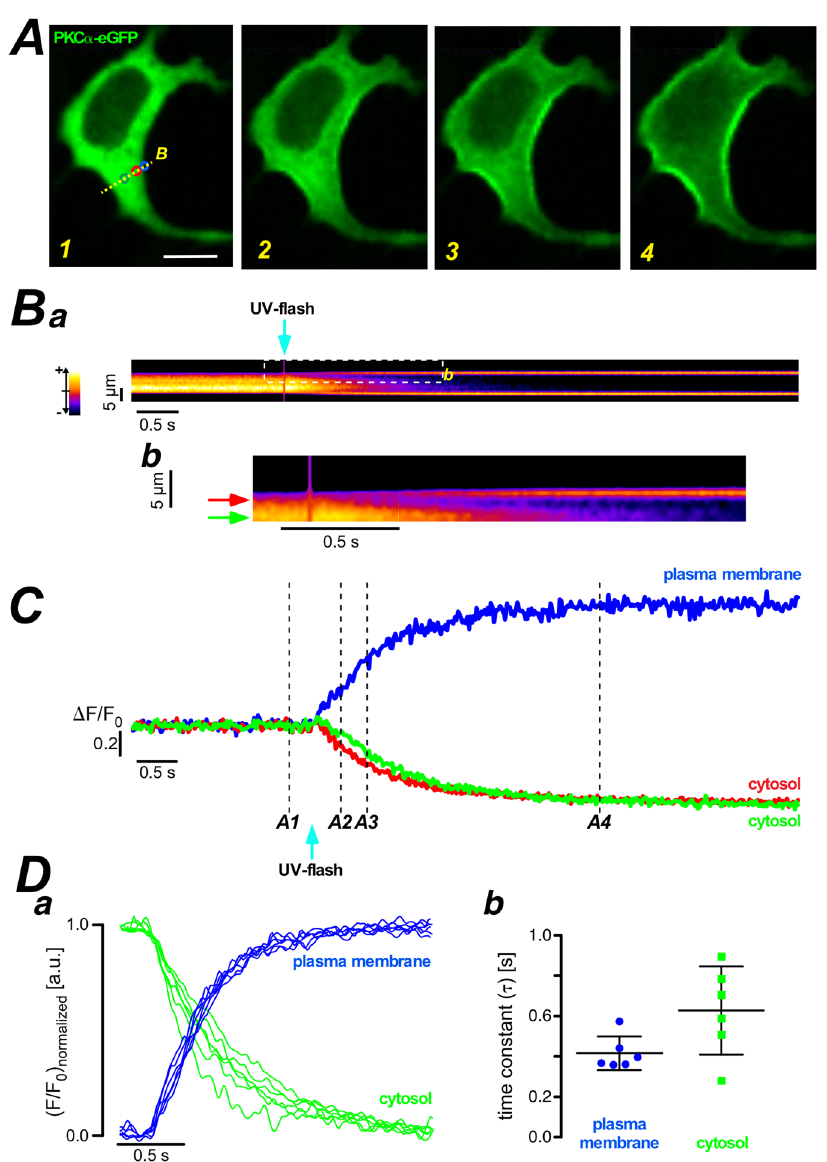
Figure 1. Quantitative analysis of PKC α -eGFP translocation from cytosol to plasma membrane. ( A ) PKC α -eGFP distribution in HEK293 cells at the resting state – left panel. Fluorescent images of PKC α -eGFP distribution upon UV-flash in NP-EGTA loaded HEK293 cells at the time points indicated in ( C ). Scale bar is 10 μ m. (Ba) The pseudo line scan at the labeled position (yellow dash line in the panel A1). Part of the pseudo line scan image (dashed box) was redrawn at a higher magnification in (Bb). The color wedge in (Ba) shows the color-coding of the relative fluorescence changes as indicated. ( C ) Plots of fluorescence over time at the plasma membrane (blue) and the cytosol (green and red) from the regions of interest, marked in panel A1. The numbers at the traces correspond to the numbered images in ( A ). ( Da ) Fluorescence over time plots of 6 regions of interest randomly chosen in the cytosolic (green) and at the plasma membrane (blue). (Db) Statistical summary of the analysis of the time constant for the traces depicted in the left panel. The scatter plot depicts individual values (symbols), the mean and the standard deviation. Similar results were found in all 7 cells analyzed in a similar